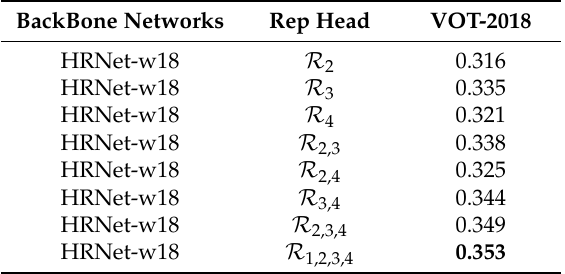
Figure 4. The Top-1 accuracy on ImageNet vs. the Area-Under-Curve (AUC) score on OTB-2015 [28]. Table 2. Analysis of the impact of different representation heads in HRNet-w18 on VOT-2018 dataset.